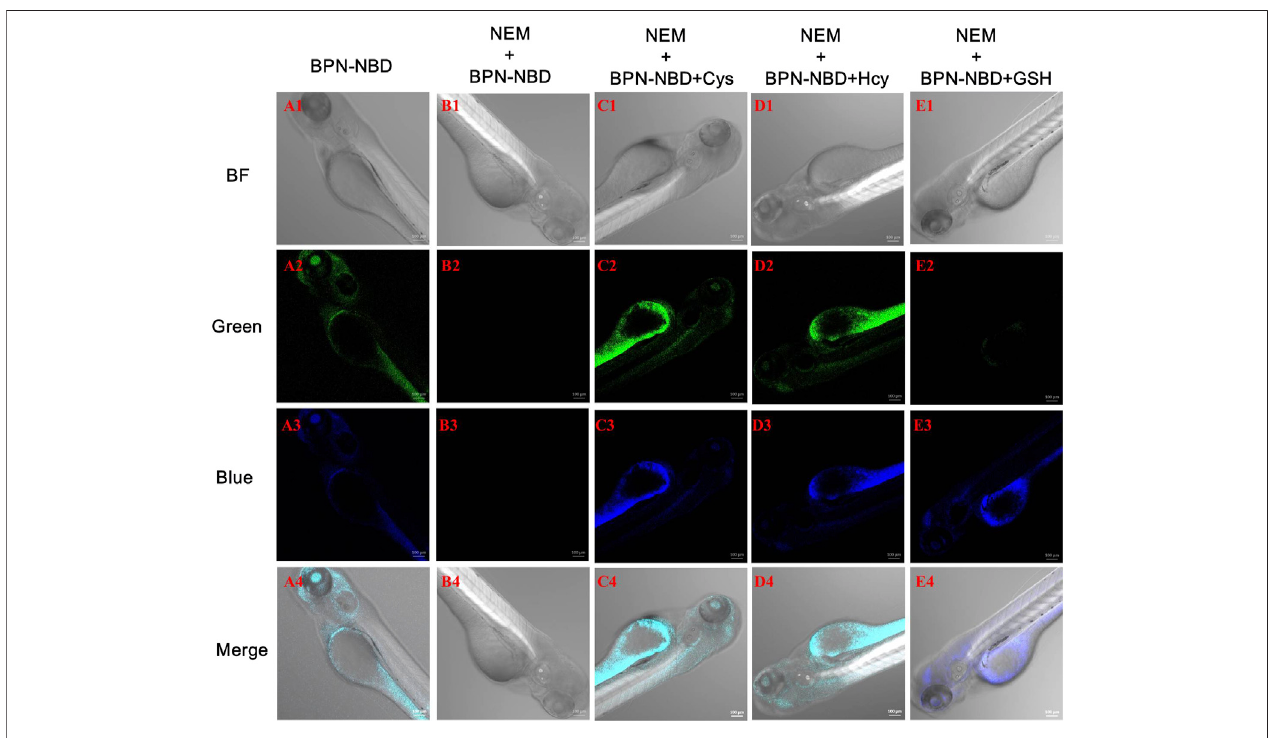
FIGURE5| TheimagesofBPN-NBD respondingtobiothiolsinzebra fi sh. (A) Zebra fi shincubated withBPN-NBD (10.0 µM)alone for30 min. (B) Zebra fi shtreated with NEM (1.0 mM) and then incubated with BPN-NBD (10.0 µM) for 30 min (C – E) Pre-treated NEM zebra fi sh incubated with (150.0 µM Cys/Hcy or GSH, respectively) for 30 min and then treated with BPN-NBD (10.0 µM) for another 30 min. The confocal imagings (bright- fi eld and fl uorescence at green/blue channel) were collected. Emissions were collected at 425 – 475 nm for the blue channel (excitation wavelength: 405 nm) and 515 – 550 nm for the green channel (excitation wavelength: 488 nm). Scale bar: 100